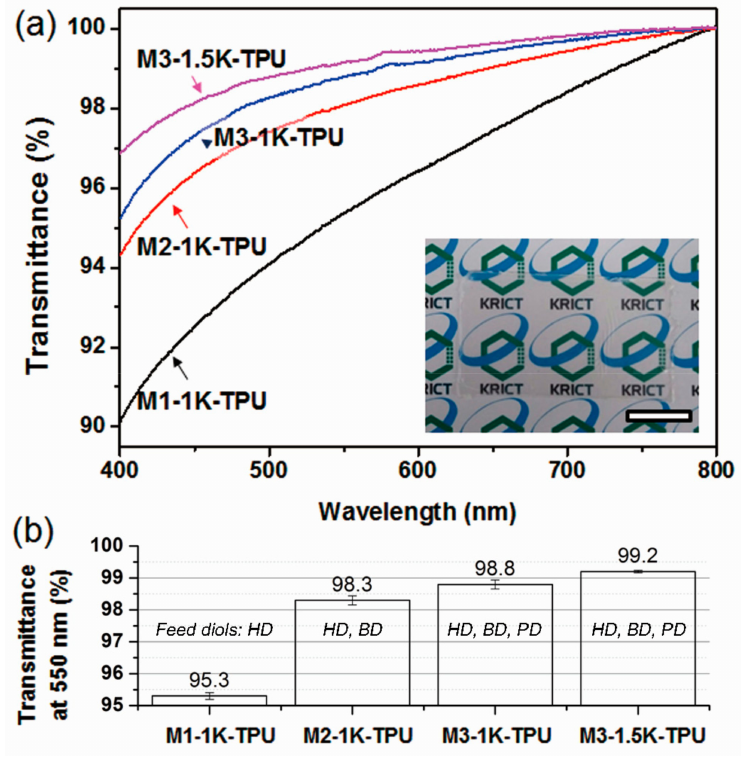
Figure 5. ( a ) Transmission spectra and ( b ) transmittance at 550 nm of TPU films with a thickness of 75 µ m (inset: photograph of the film of M3-1.5K-TPU ; scale bar = 2